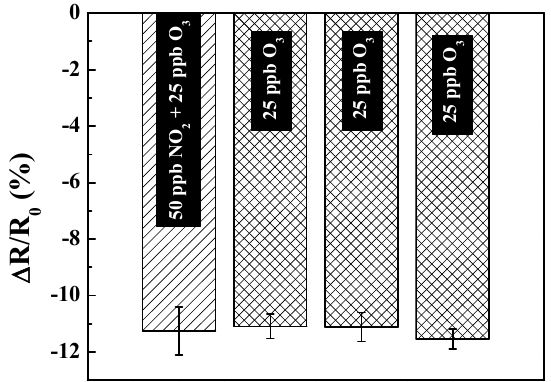
Figure 5. Response ( ∆ R / R 0 ) of KI-PANI device towards pure O 3 (25 ppb) and mixed gas [O 3 (25 ppb) + NO 2 (50 ppb)] at 25 °C and 50% RH. Data points are average of responses from three independent sensors, and error bars represent ±1 standard deviation.